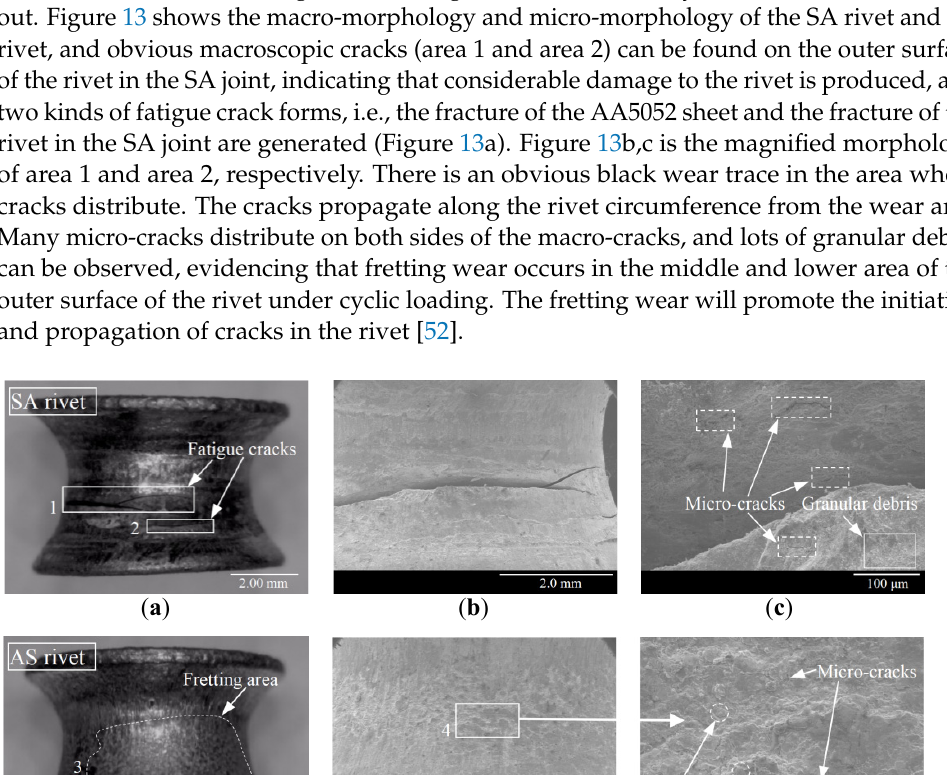
Figure 12. Fatigue failure modes of SPR joints. ( a ) SA; ( b ) AS-1; ( c ) AS-2; ( d ) SAT; ( e ) AST; ( f ) SAF.